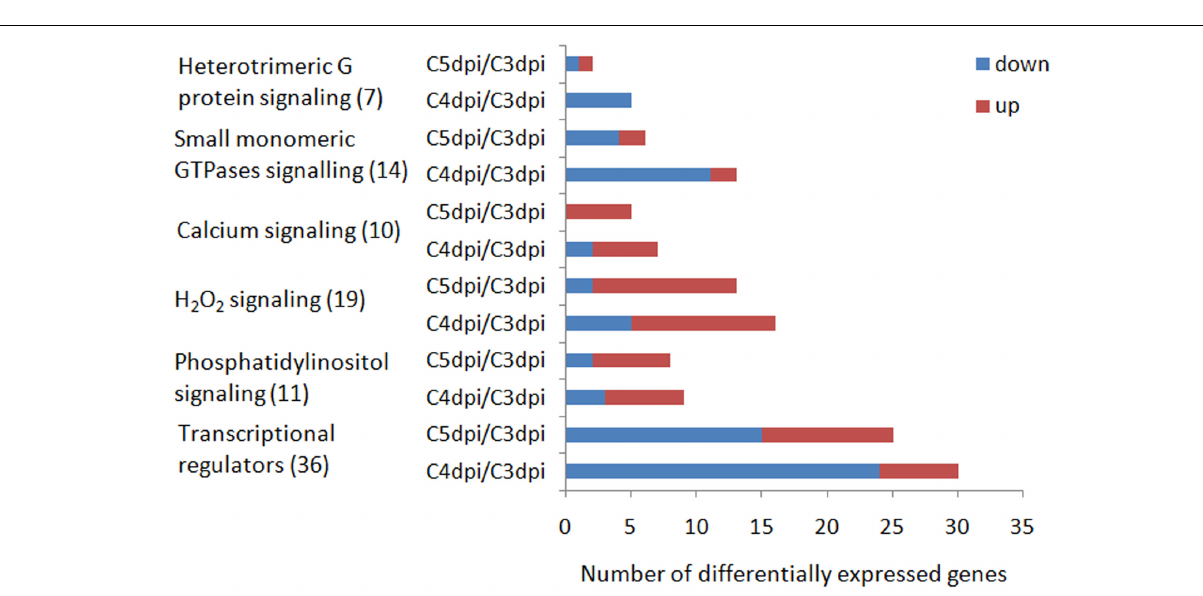
FIGURE 5 | Number of DEGs coding for putative signaling proteins and transcriptional regulators up-regulated or down-regulated during conidiation of Bgt . Numbers in the brackets are the corresponding number of genes in each signaling pathway or function category. Up and down represent up-regulation and down-regulation,